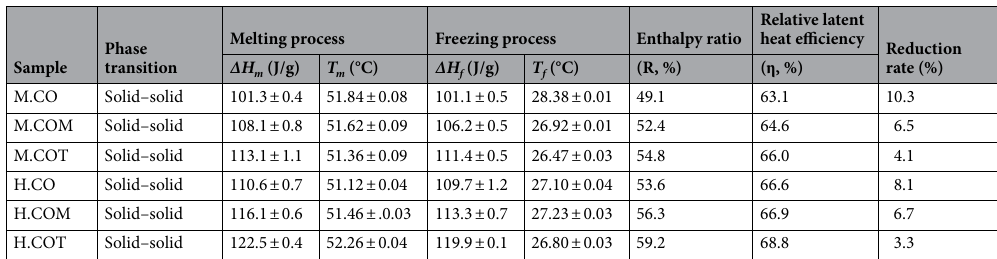
Table 4. Phase-change characteristics for the SSPCMs calculated from 5 consecutive DSC scans after accelerated thermal cycling test.